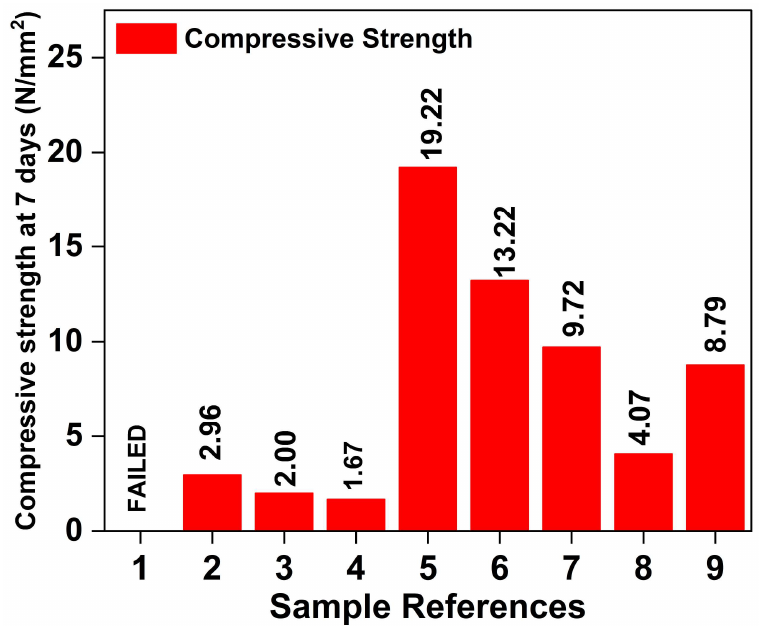
Figure 1. Compressive strength at 7 days of curing age—Stage 1.